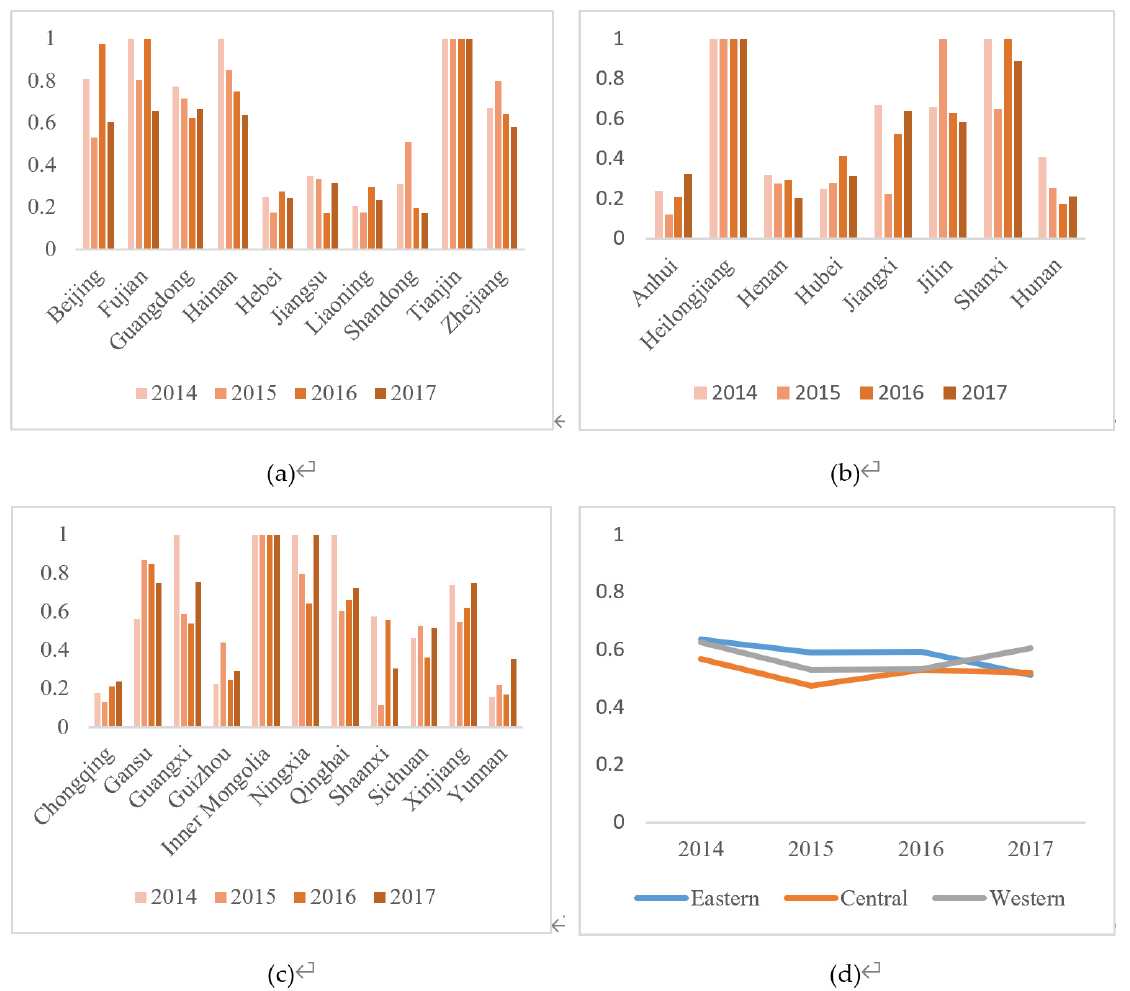
Figure 3. Overall efficiencies: (a) Eastern China; (b) Central China ; (c) Western China; and (d) comparison of the three